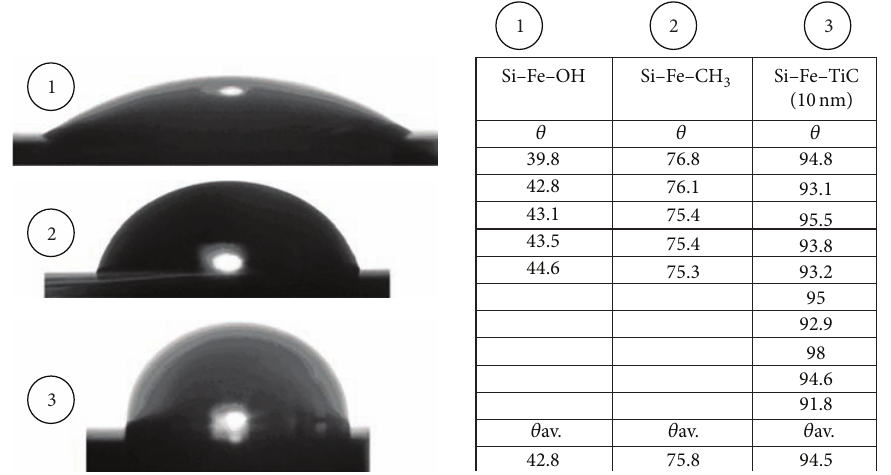
Figure 4: The values of contact angles by water for silicon samples with iron layer with different functional groups: (1) ≡ Si–Fe–OH, (2) ≡ Si–Fe–TiC. ≡ Si–Fe–OCH 3 , and (3)